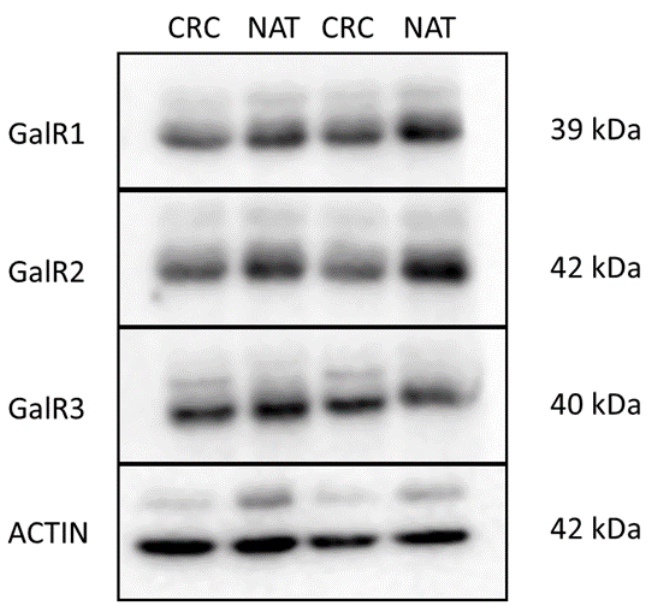
Figure 4. GalR1-3 proteins levels in the colorectal cancer tissue (CRC) and normal adjacent tissue (NAT) of large-intestine tissues of colorectal cancer patients ( n = 5). Representative blots of studied tissues are shown above the graph. β -actin (ACTB) was used as the loading control.